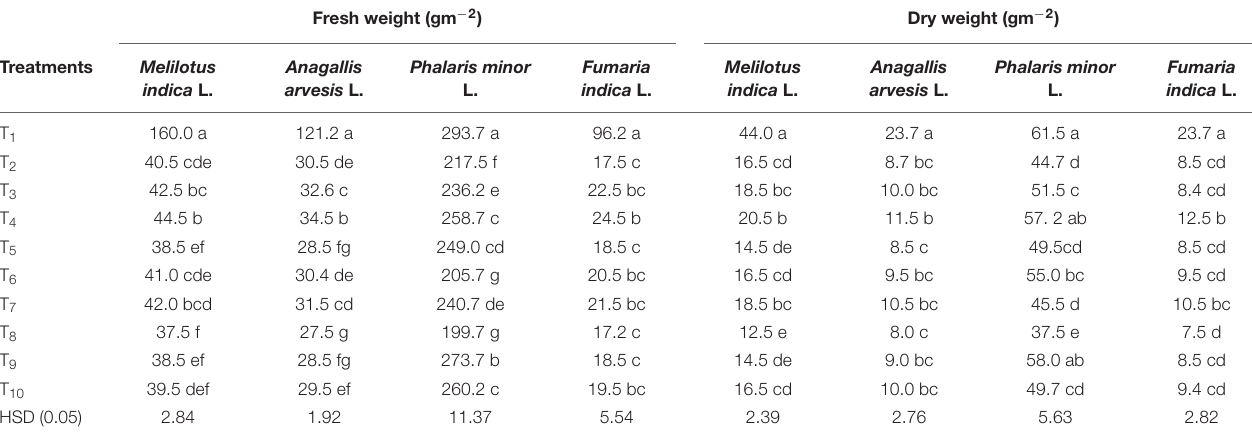
TABLE 4 | Influence of metribuzin alone and with adjuvants on fresh and dry weight (g) of weeds growing in wheat (average of 2 years’ data). Fresh weight (gm − 2 )